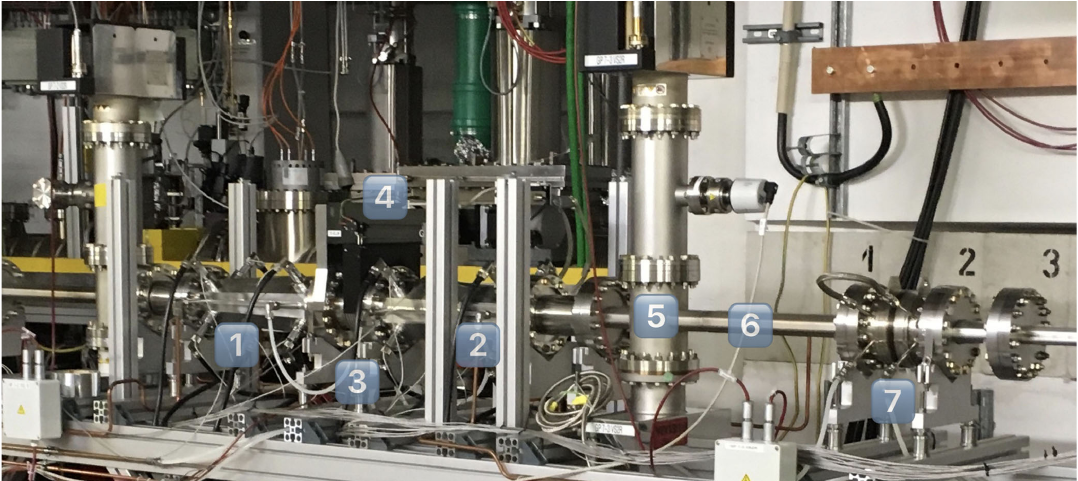
FIG. 8. The installation of the CSB1/CSB2 test setup in the BESSY II storage ring. The taper setup (1), (2) keeps the CSB (3) in the middle, where a linear mover (4) can adjust its length remotely controlled. The downstream taper (2) together with the attached pumping dome (5) and beam pipe (6) move as a whole; length compensation is provided with a conventional bellow